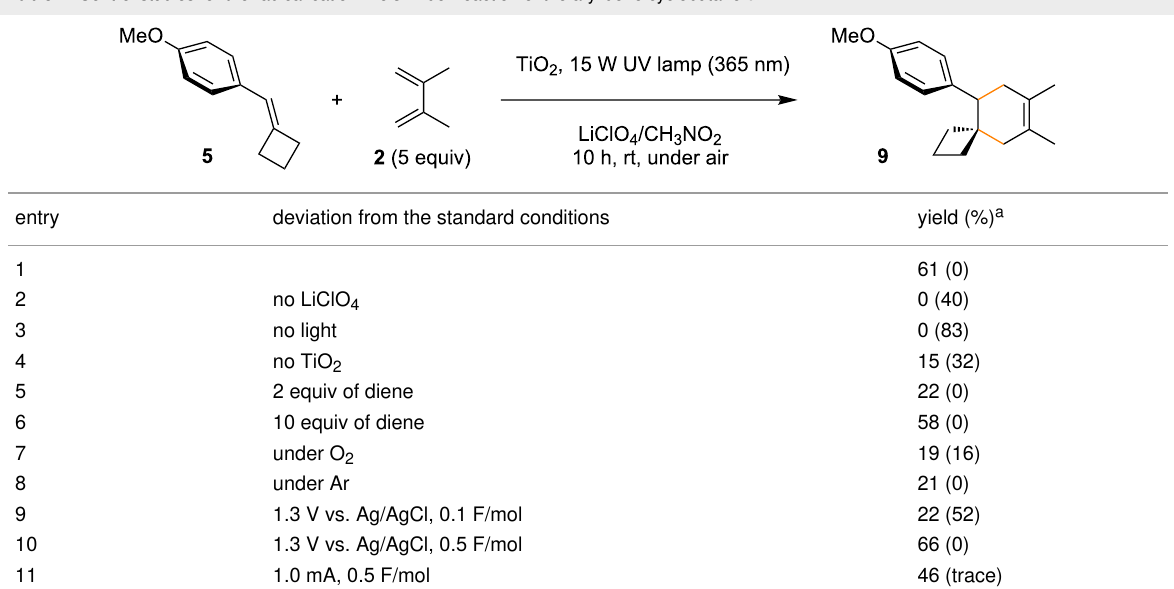
Table 1: Control studies for the radical cation Diels–Alder reaction of the arylidene cyclobutane 5 .